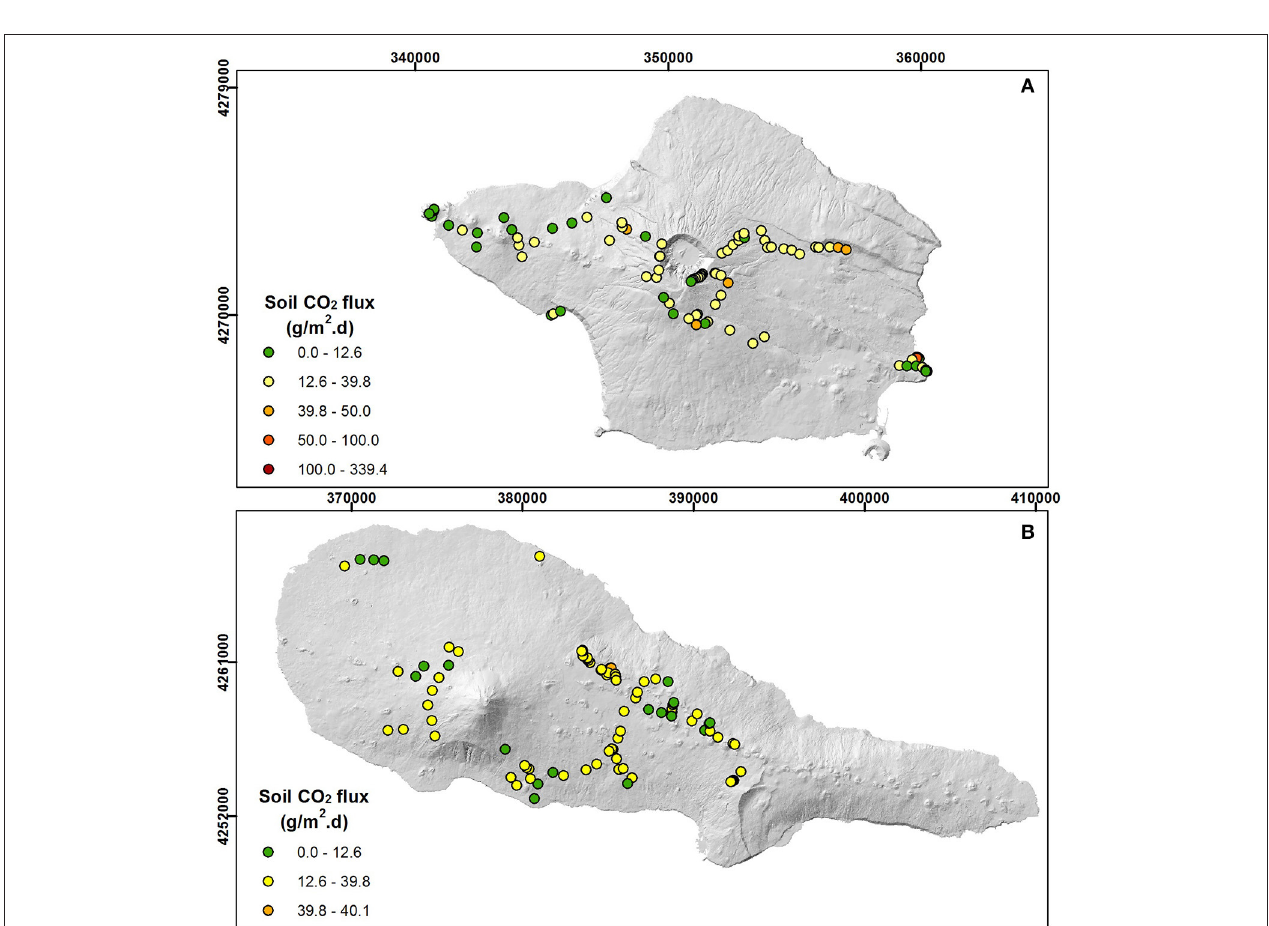
FIGURE 4 | Sampling location and soil CO 2 flux distribution maps for Faial (A) and Pico (B) islands.